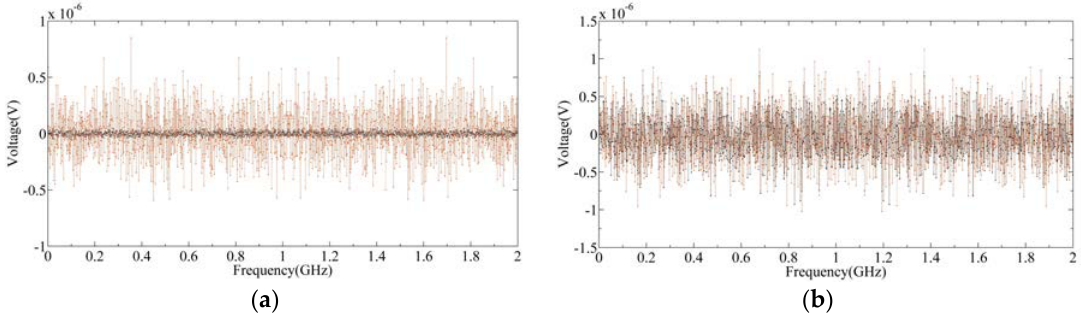
Figure 7. Signal spectrum of cold and hot targets at the frontend of the 240 GHz S5 spectrometer, where the red dot represents the hot target and black dot represents the cold target: ( a ) Tsys = 0 K; ( b ) Tsys = 1000 K.